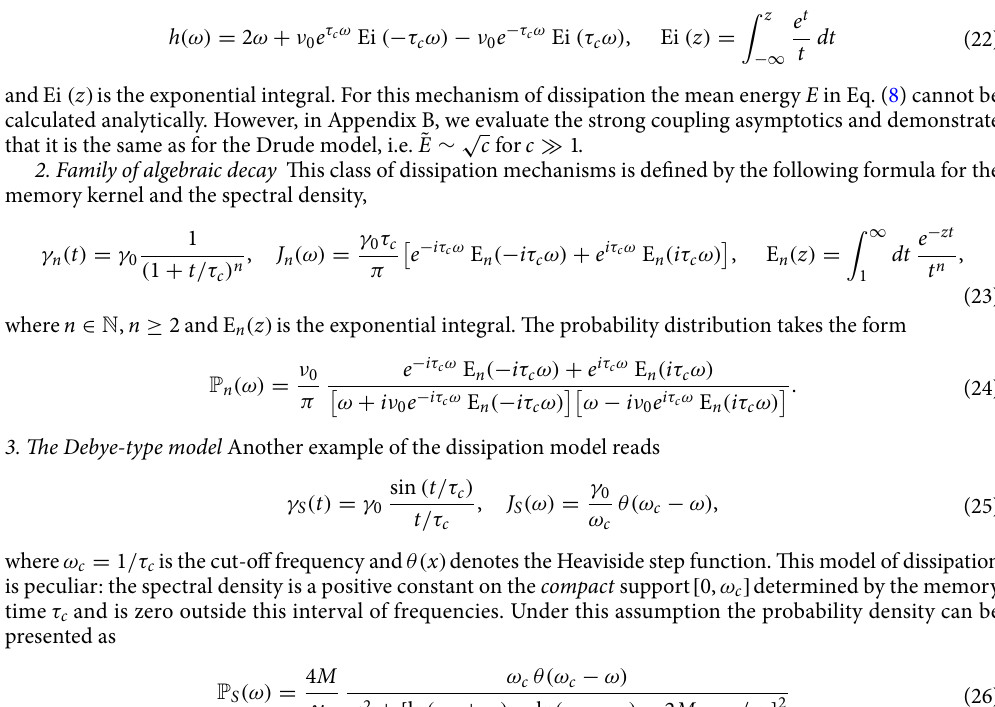
Figure 2. ( a ) The average energy of the quantum Brownian particle ˜ t ) mechanisms. ( b ) The dissipation kernel ˜ γ( , ( c ) the spectral density ˜ ˜ F ( ˜ ω) and ( e ) the correlation function C 0 ( ˜ t ) of quantum noise, in inset we present the magnified function correlation functions for the Debye and Lorentz case. The dimensionless quantities are: ˜ γ( ˜ ˜ J ( ˜ ω) = (ω c /γ 0 ) J (ω c ˜ ω) , C 0 ( ˜ t ) = 2 C 0 ( ˜ t /ω c )/(γ 0 (cid:31) ω c ) . The dimensionless variables are: F ( ˜ ω) = F (ω) and ˜ t = ω = 0.25 ˜ ω = ω/ω c t and c . In ( d ) c